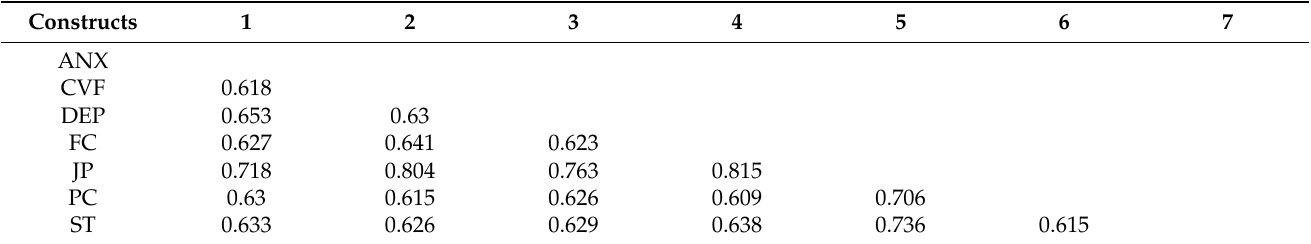
Table 7. Variance Influence Factor.